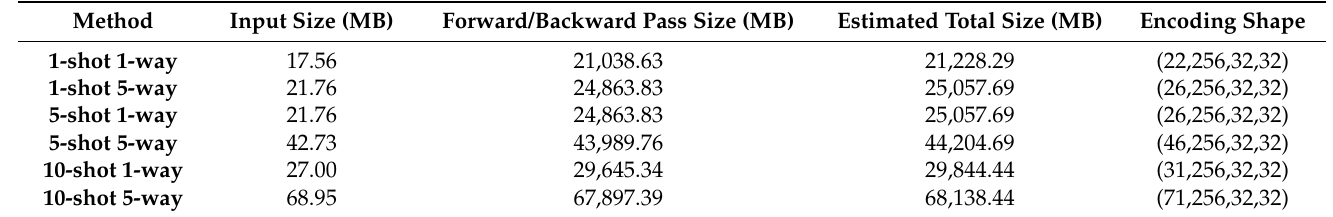
Table 1. Encoding shape (spatial) and memory usage statistics along with a feature encoding shape of (1,5,10)—shot (1,5)—way learning